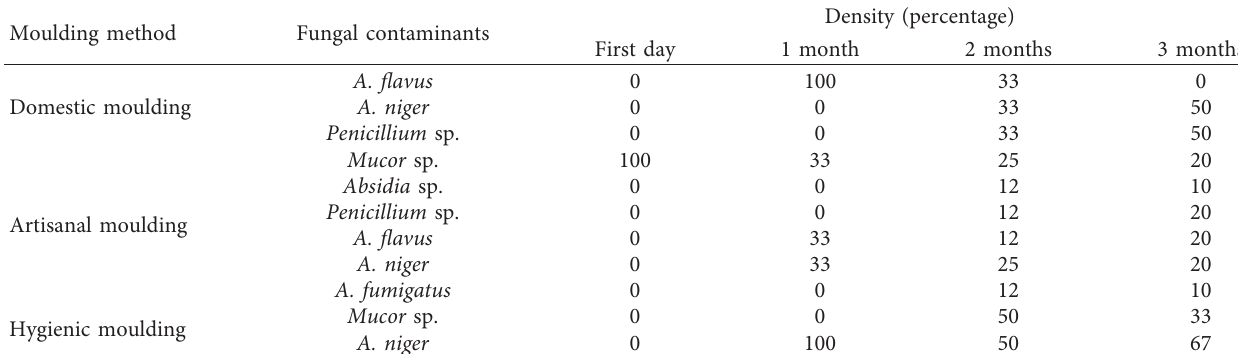
Table 4: Density of fungal